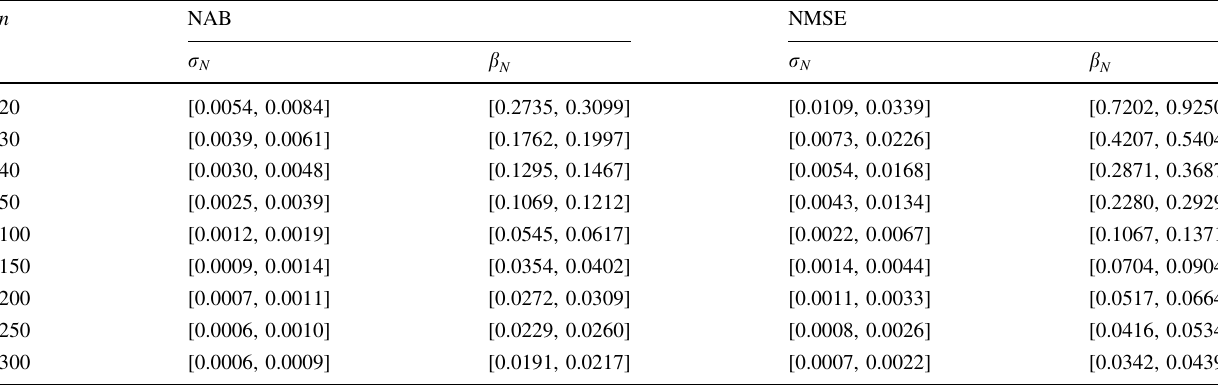
Table 3 Simulated average neutrosophic biases and MSEs of parameters when r N 2 1 ; 2 ½